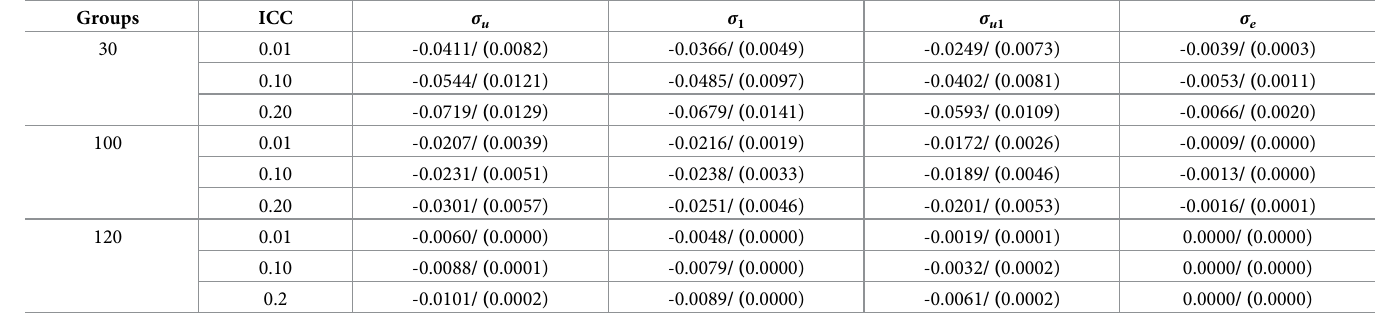
Table 2. Average relative parameter bias of the random effects estimates obtained for normal distribution data (First = REML estimation procedure, Second = Bootstrap estimates are enclosed in Parenthesis).